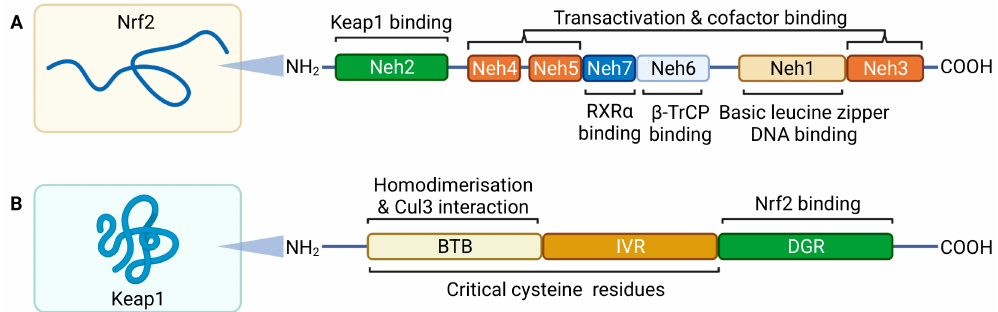
Figure 2. Nrf2 and Keap1 structure. Nrf2 ( A ) is comprised of seven functional Neh domains. Neh2 is required for Keap1 dependent homeostatic regulation. Neh3, Neh4, and Neh5 are required for transactivation and facilitatory cofactor binding and Neh1 contains the DNA binding basic leucine zipper domain. Neh6 and Neh7 contain sites that allow redox independent Nrf2 inhibition. Keap1 ( B ) contains two major domains that are relevant to Nrf2-regulation. The broad complex, tramtrack and bric a brac (BTB) domain is required for formation of the Keap1 homodimer-Cul3 complex and the double glycine repeat (DGR) anchors Nrf2 and actin to maintain Nrf2s cytoplasmic localisation during steady state. Oxidation of cysteine residues located in the BTB and intervening region (IVR) result in conformational change that releases Nrf2. Adapted from Jaramillo and Zhang (2013) [132]. Created with